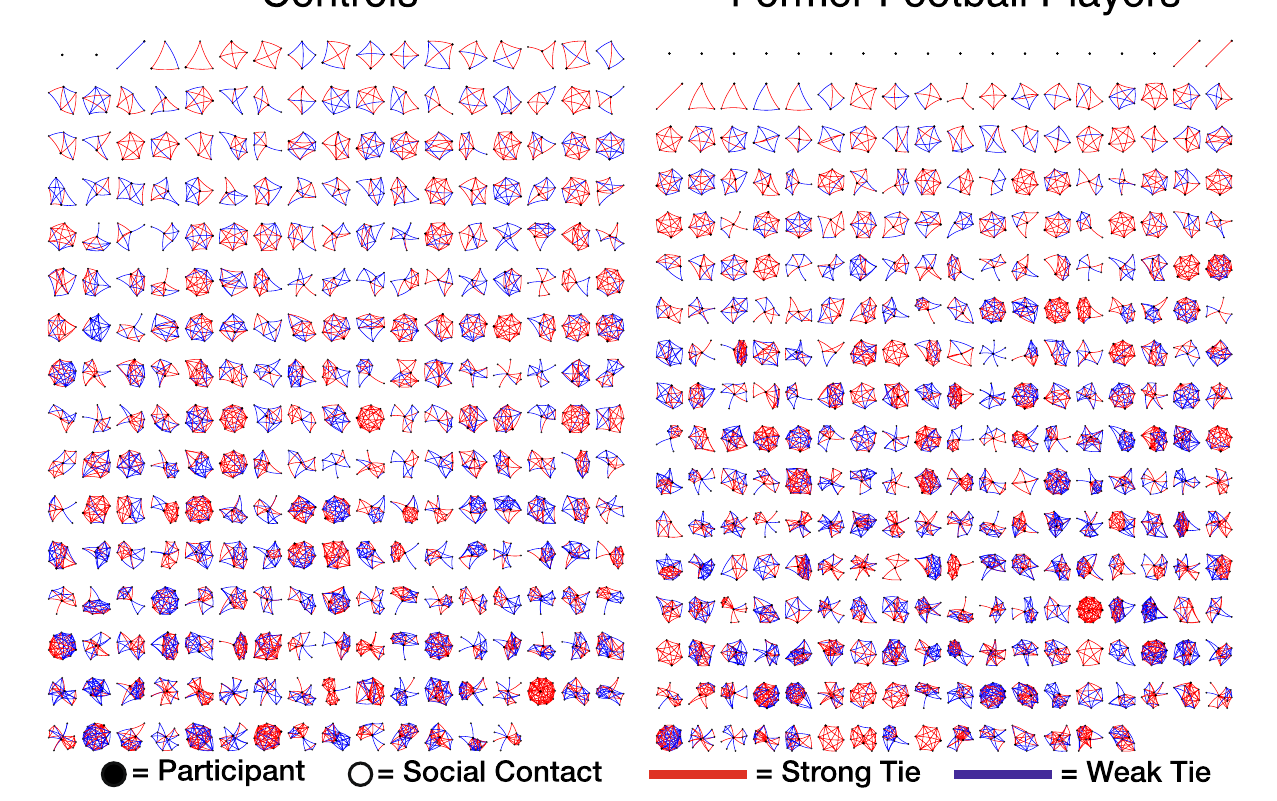
Figure 1. Personal networks of controls and former football players. Networks are arranged from smallest (top left) to largest (bottom (42.3% versus 26%). There were no differences in marital status, employment, football experience, concussion symptoms, mood, weight, or smoking status. Social network structure and composition of former NFL football players and US con‑ trols. The former football players described 2575 network members, and the US controls described 2305 network members. A montage of all participants’ personal networks is displayed in Fig. 1, highlighting the range of small to large networks. Overall, the social networks were structurally similar across the two groups (Table 2, Supplement Fig. 1). Network size did not differ after accounting for age, race, education, employment status, median yearly income, and domestic status. The median, interquartile range [IQR] of network size for football players versus US controls was 8 [5, 11] versus 7 [6, 10], p = 0.499. All other metrics of network typology were likewise not statistically different. The composition of the networks differed across the groups in two ways (Table 2). Former football players had more men than women in their networks, as indicated by the lower median [IQR] Diversity of Sex (0.84 [0.64, 0.96] versus 0.94 [0.83, 0.98], p = 0.001) (Fig. 2). Secondly, the percentage of network members who were family members was less in the football players compared to controls (40.00% [22.22, 60.00] versus 42.86% [33.33, 62.50], p = 0.045). All other social network composition metrics were similar in the main comparison. Football affiliations were only asked of the players cohort. Players’ networks had a median 40.00% [25.00, 60.00] of members who had played organized football (high school, college, professional). However, the networks rarely included members who played professional football. 196 participants (64.9%) had no NFL contacts, and 91 participants (30.0%) had only one NFL contact. In terms of playing with the participant, 14.29% [0.00, 33.33] of network members were former teammates or coaches in organized football. However, 0.00% [0.00, 0.00] were former teammates or coaches at the professional level. Network metrics stratified by race. We stratified the football players’ cohort into two groups, White (n = 222) and Black/Other (n = 79). We compared each group to each other, and then to controls, whose partici- pants were 96% White. Network structure did not differ between the race sub-groups and controls, showing no difference from the full group findings (Supplement Table 2). There were differences in network composition in the race sub-groups, and particularly Diversity of Race (Fig. 3, Supplement Table 3). Black/Other former football players had a markedly higher diversity in their networks (0.42 [0.06, 0.78]) compared to White former football players (0.00 [0.00, 0.00]) and controls (0.00 [0.00, 0.26], p < 0.001). As displayed in Fig. 3, Black/Other football players were embedded in racially diverse